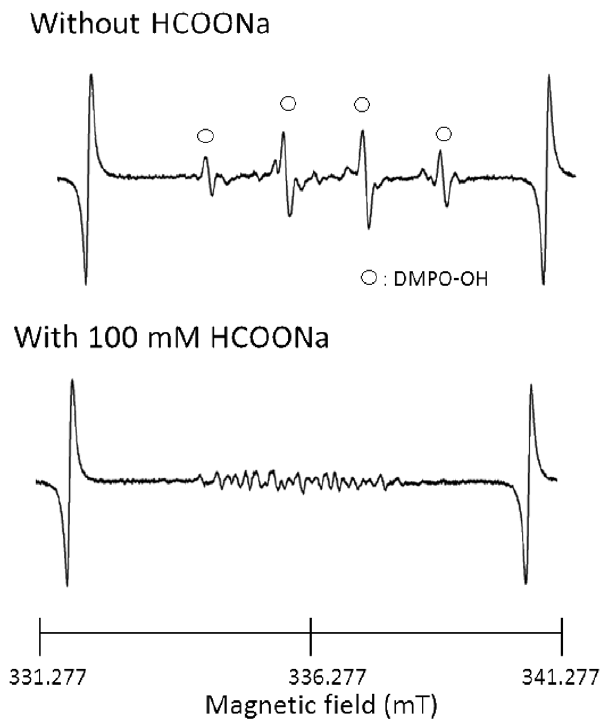
Figure 7. ESR spectra of AEW prepared by triple electrolyses of 1% NaCl solution. Spectra in the absence and presence of HCOONa are shown.